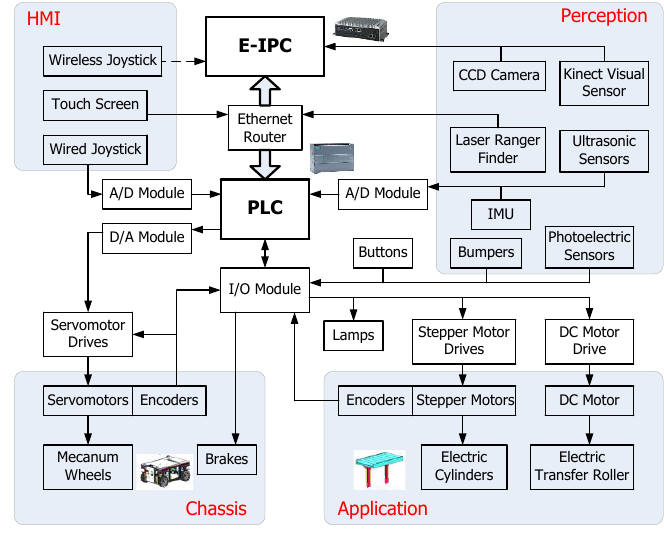
Figure 4. Block diagram of RedwallBot-1’s control system.